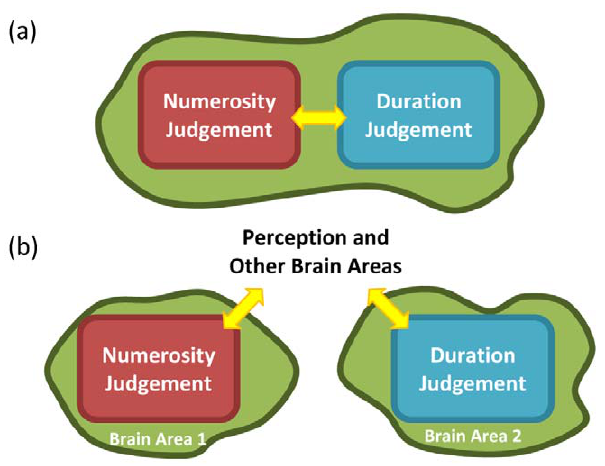
Figure 5. Two possible mechanisms explaining the effect of training on interference of numerosity on duration judgement. (a) based on the commonalities of numerosity and duration judgement, (b) through higher levels of cognition and other brain areas involved for numerosity and duration perception.